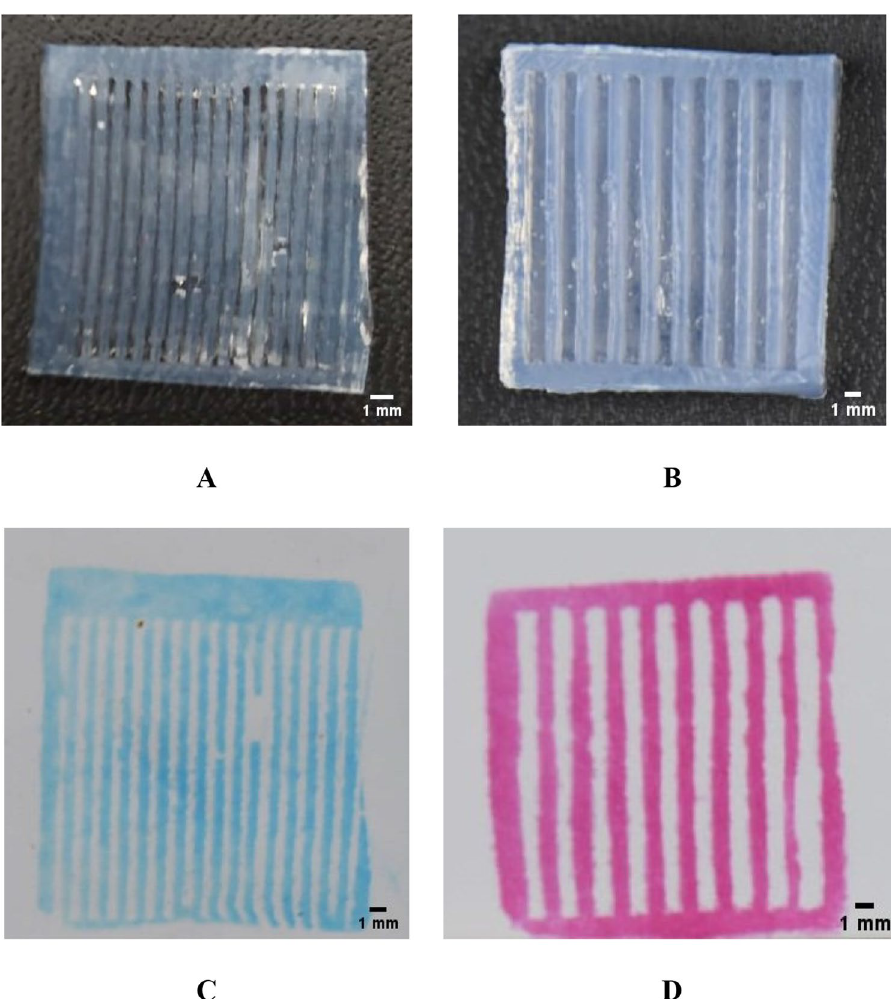
Figure 3. Agarose-micropattern stamp 500 µm ( A ), 1000 µm ( B ); and stamping results of 500 µm ( C ), 1000 µm ( D ) agarose-micropattern stamp using